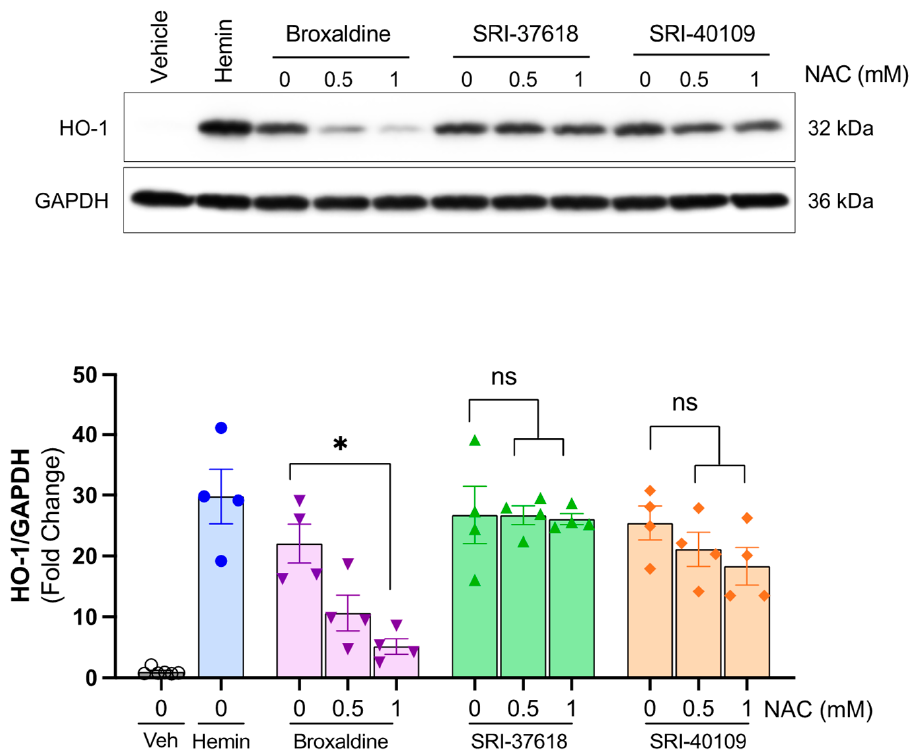
Figure 4. Top panel: Representative Western blot analysis for HO-1 in HEK293 cells treated with broxaldine (5 µM), SRI-37618 (0.5 µM), SRI-40109 (5 µM), hemin (5 µM), or vehicle (DMSO) in the presence of 0, 0.5, or 1 mM N-acetylcysteine (NAC). Lower panel: HO-1 induction normalized to corresponding GAPDH expression and expressed in arbitrary units relative to vehicle control. Each dot represents an independent experiment (n = 4). Data analyzed with one-way ANOVA and Šídák’s multiple-comparison test. Error bars display SEM. ns = not significant, ✱ p < 0.05.